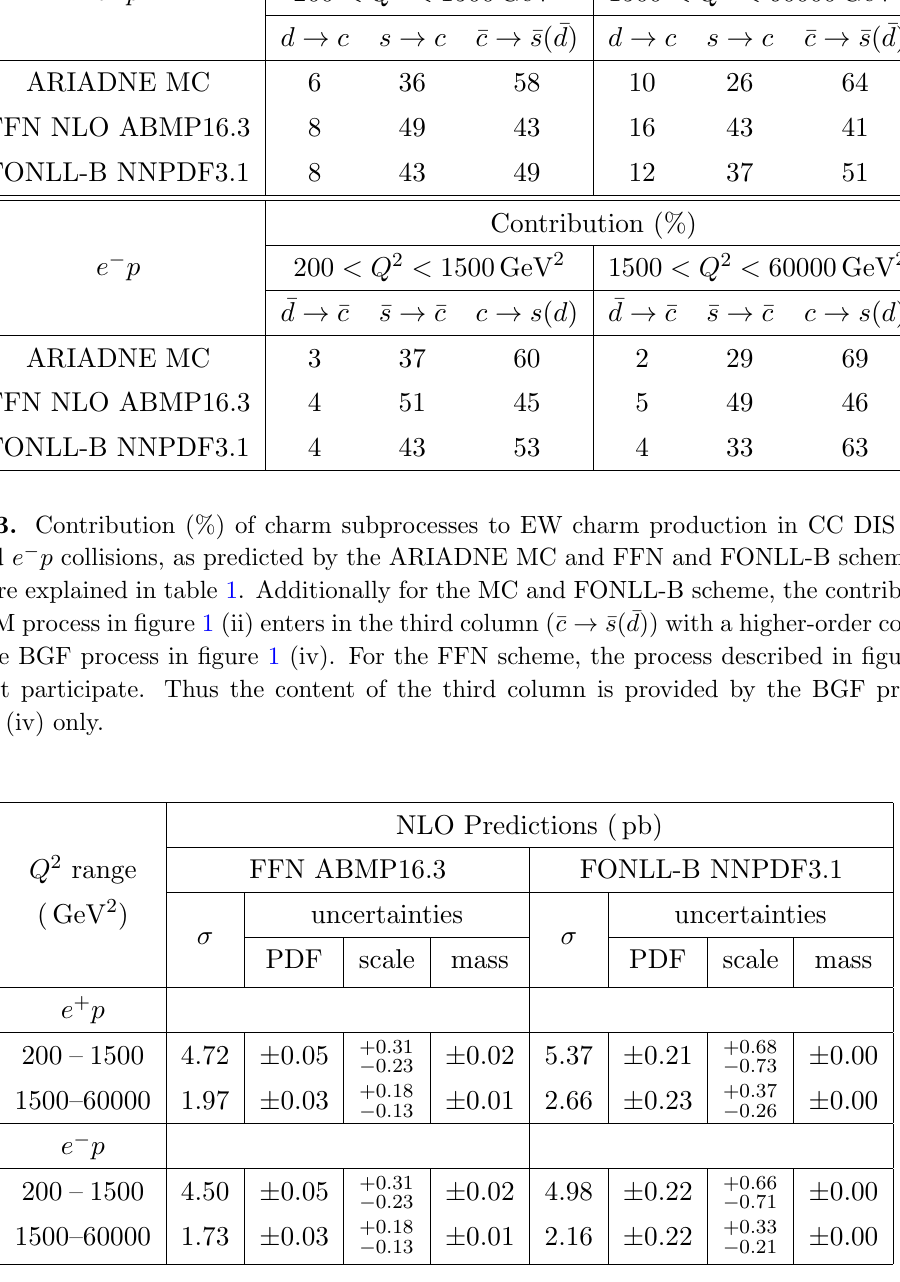
Table 4. The NLO theory predictions from the FFN and FONLL-B schemes with their full uncertainties. The scale uncertainty was obtained by varying the renormalisation and factorisation scales simultaneously up and down by a factor two. The mass uncertainty was obtained by varying the charm mass, m c ( m c ), within its uncertainties m c ( m c ) = 1 : 28 (cid:6) 0 : 03